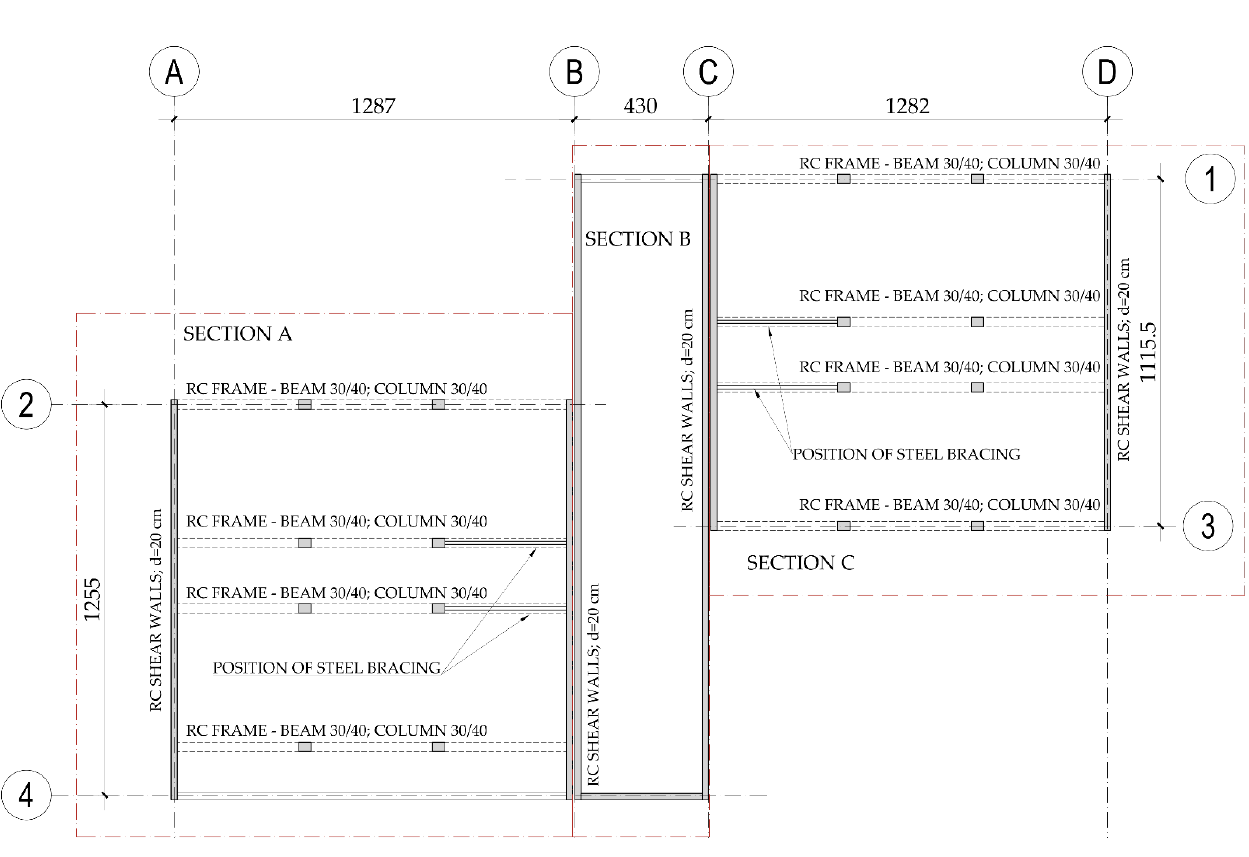
Figure 5. Characteristic floorplan of the case study building (all units in cm).